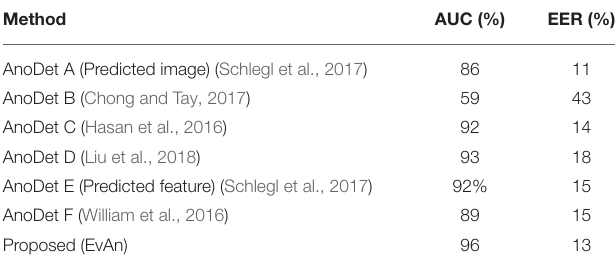
= 0.25, N 2 k = 1 (cid:17) , S2 mn = 0.25, N 2 k = 2 (cid:17) , S4 mn = 0.25, N 2 k = 5 (cid:17) at different levels in terms mn ∗ 100 (cid:17) . log D